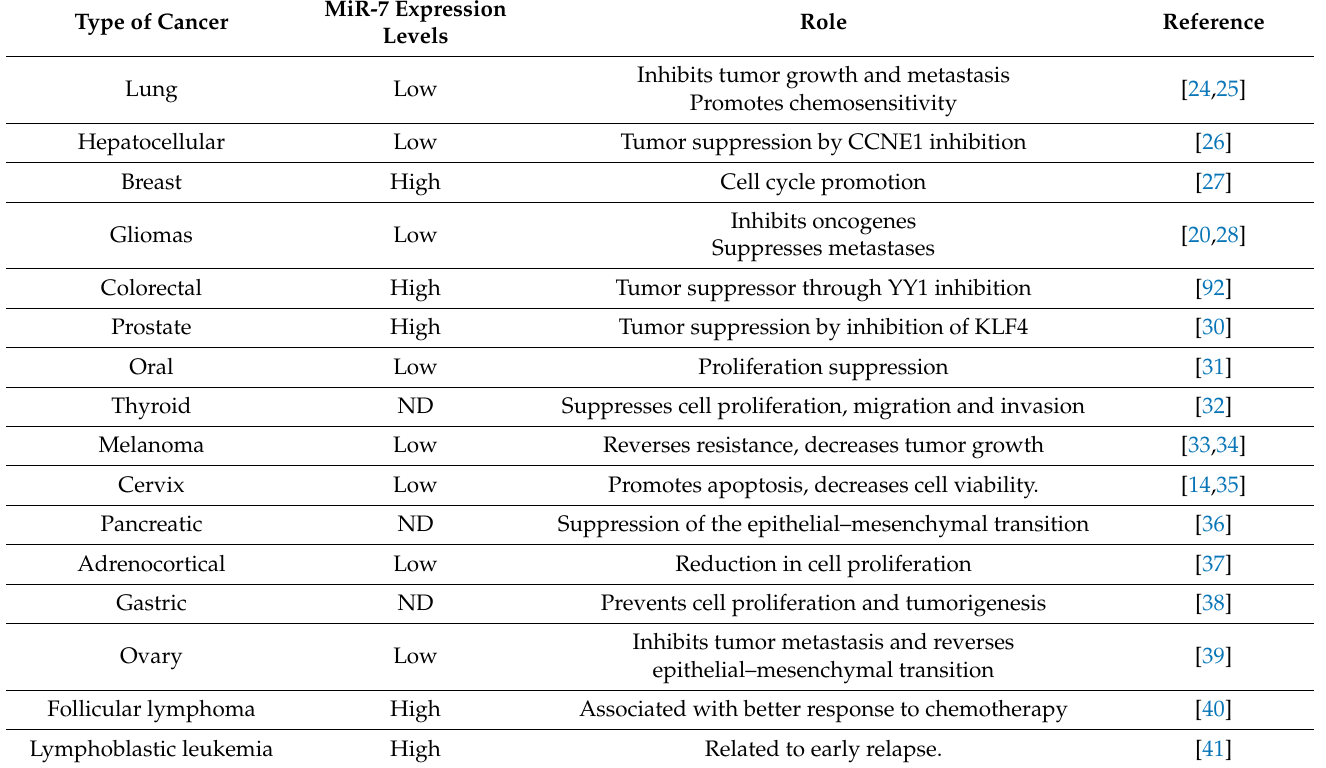
Table 2. miR-7 roles in